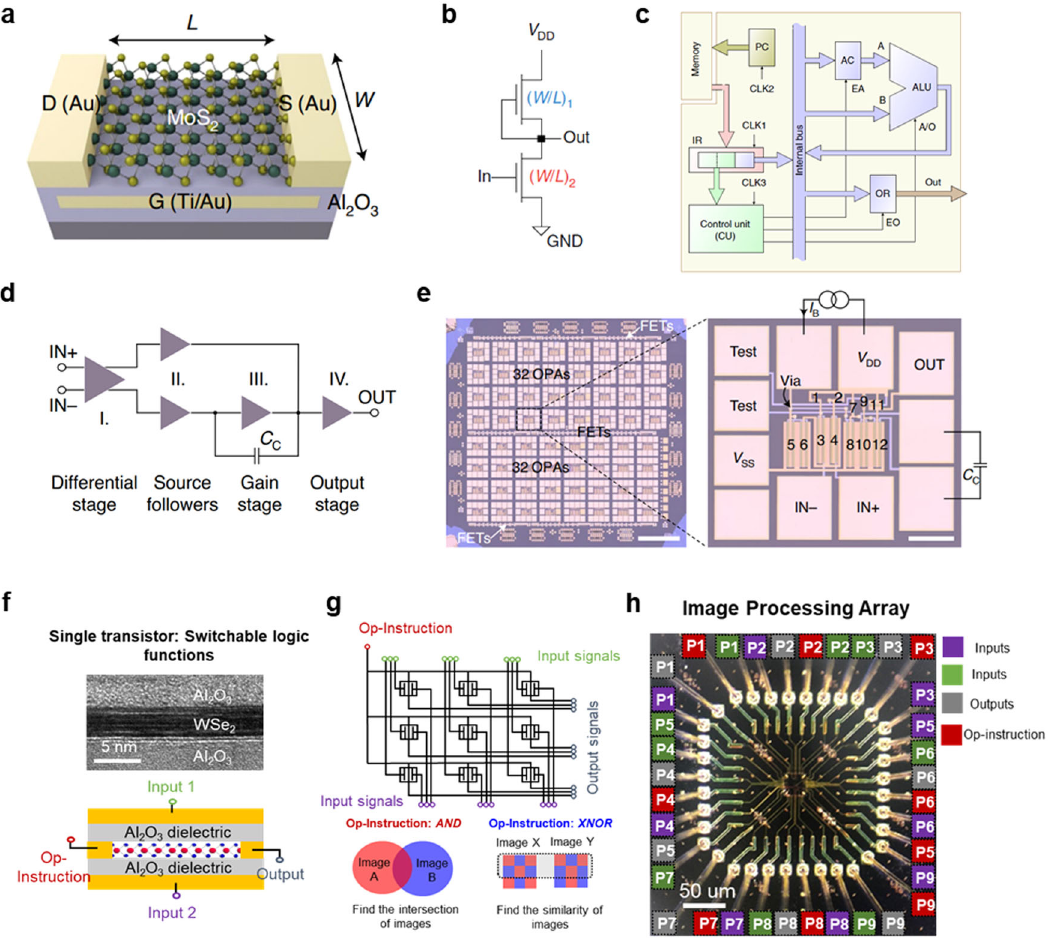
Fig. 9 Computing function arrays of 2D semiconductors. a Schematic of the back-gate architecture of MoS 2 transistor adjusted by the channel width/length ratio for integrated circuits. b Schematic of MoS 2 -based inverters using n-type enhancement-mode. c Block diagram of the MoS 2 -based 1-bit microprocessor architecture. d Block-level representation of the OPA circuit made from MoS 2 transistors. e Optical images of the MoS 2 -based analogue circuits chip. a – e are reproduced from ref. 156,157 . f Illustration of the single logic transistor with switchable functions. The top penal shows the cross-sectional TEM image and the bottom penal shows the schematic structure. g Schematic of the pixel processing array circuit based on the single logic transistor. h Optical images of the image processing pixel array with switchable functions. f – h are reproduced from ref. 158